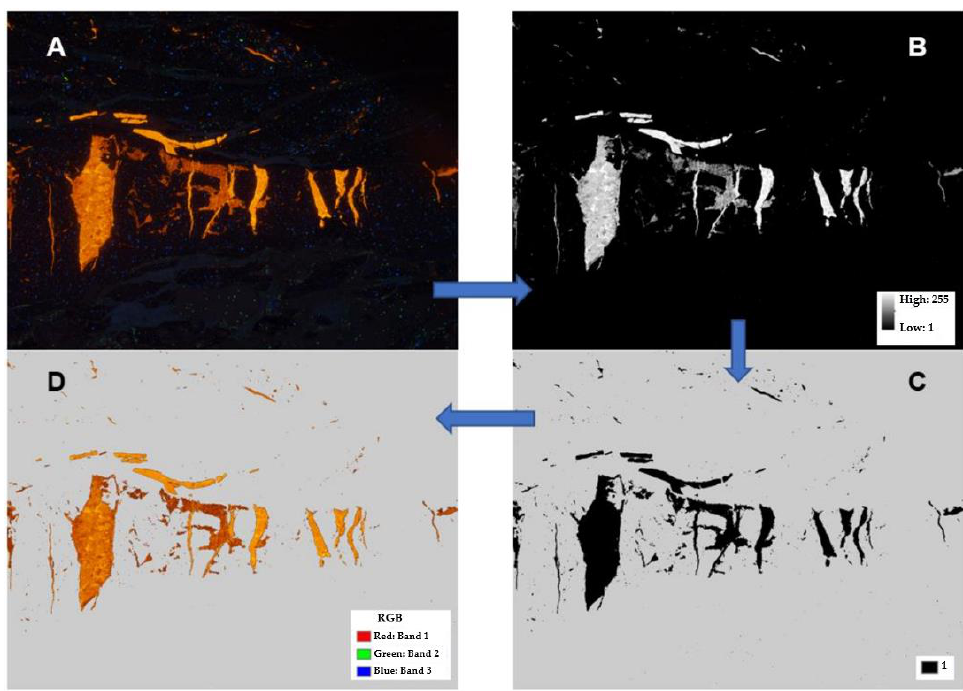
Figure 5. Intermediate data from the classification procedure including: ( A ) the raw CL image; ( B ) the raster band generated via the FM function, with pixel values indication strength of membership; ( C ) the binary mask band produced by thresholding the original FM image; and ( D ) the clipped raster containing RGB pixel values only within the calcite region defined by the mask band. Images B and D serve as the input for the unsupervised classification.